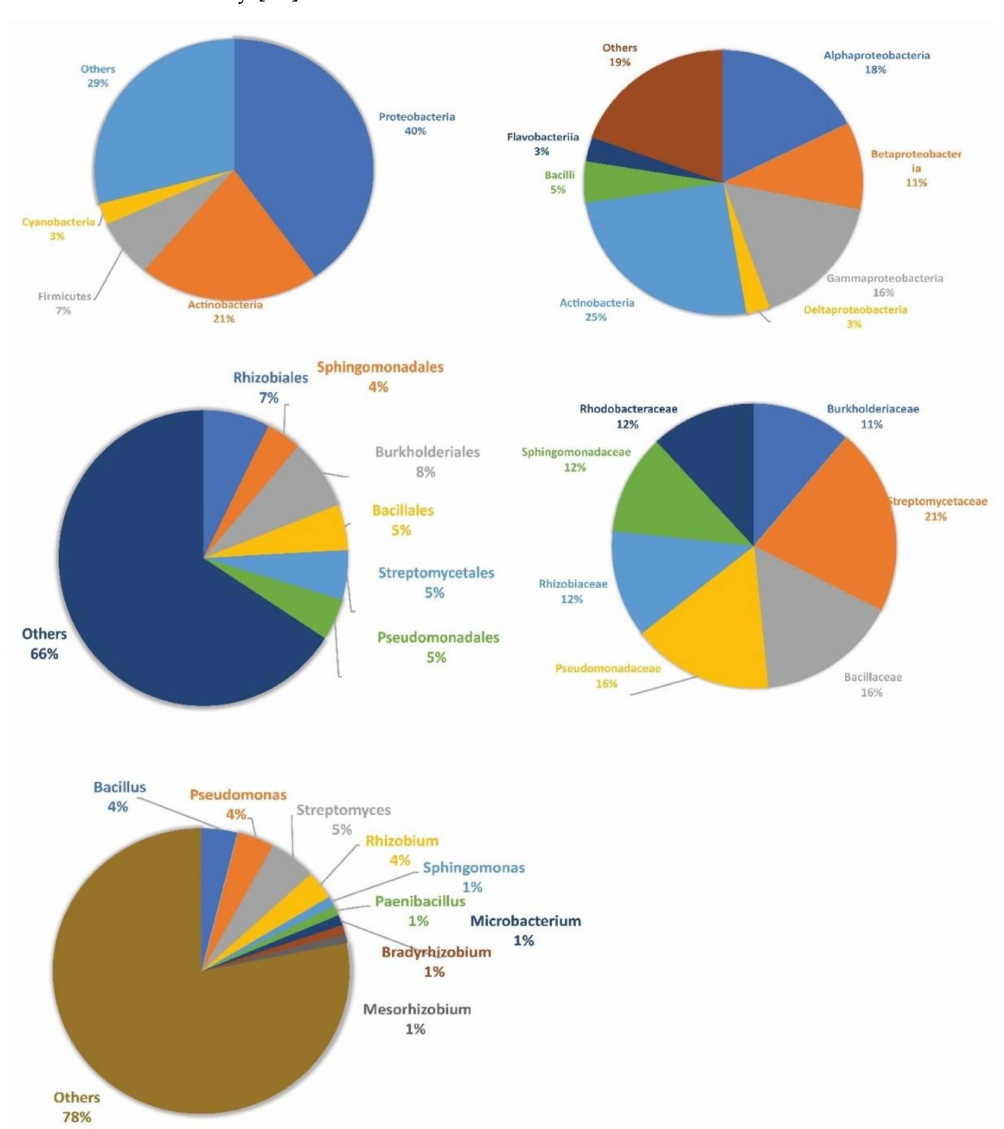
Figure 3. Abundance of various bacterial phyla, order, group, genus, and family present in ZBNF soil. Genera such as Bacillus, Pseudomonas, Streptomyces, and Rhizobium which produce various bioactive metabolites and enzymes are known. PGPR were recorded as the major bacterial community found in the ZBNF